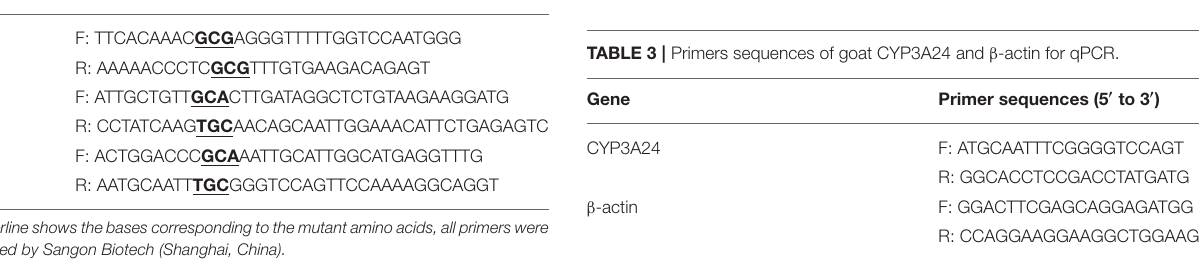
TABLE 1 | Primers used for site-directed mutagenesis. Primer